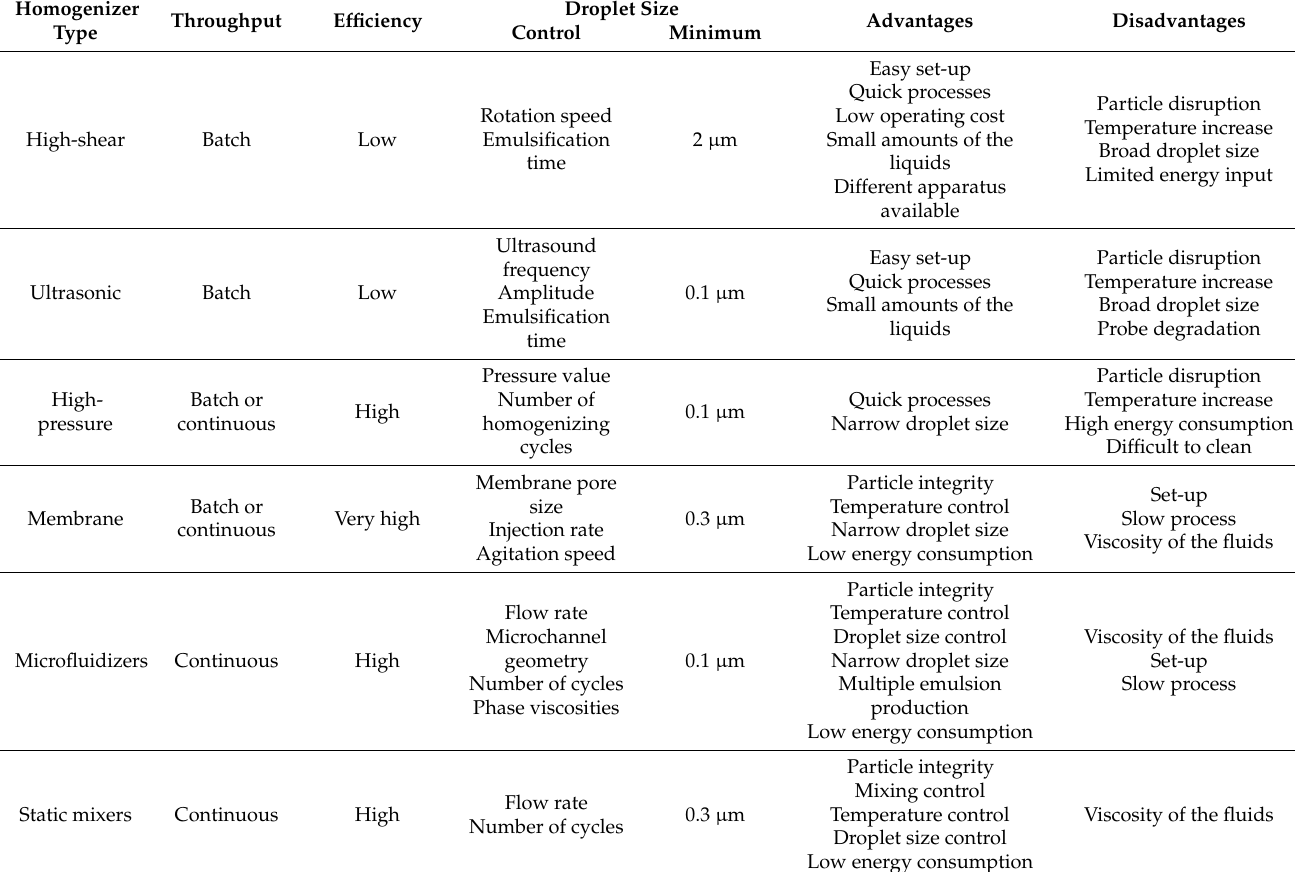
Table 3. Summary of characteristics, advantages and disadvantages of main emulsification devices used for PE